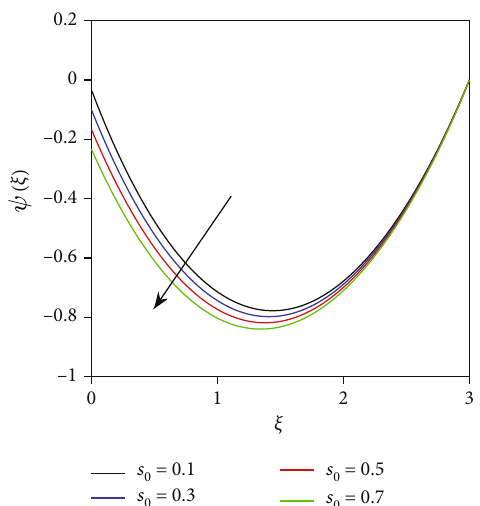
Figure 13: Microrotation ψ ð ξ Þ pro fi les for microrotation slip parameter s 0 .